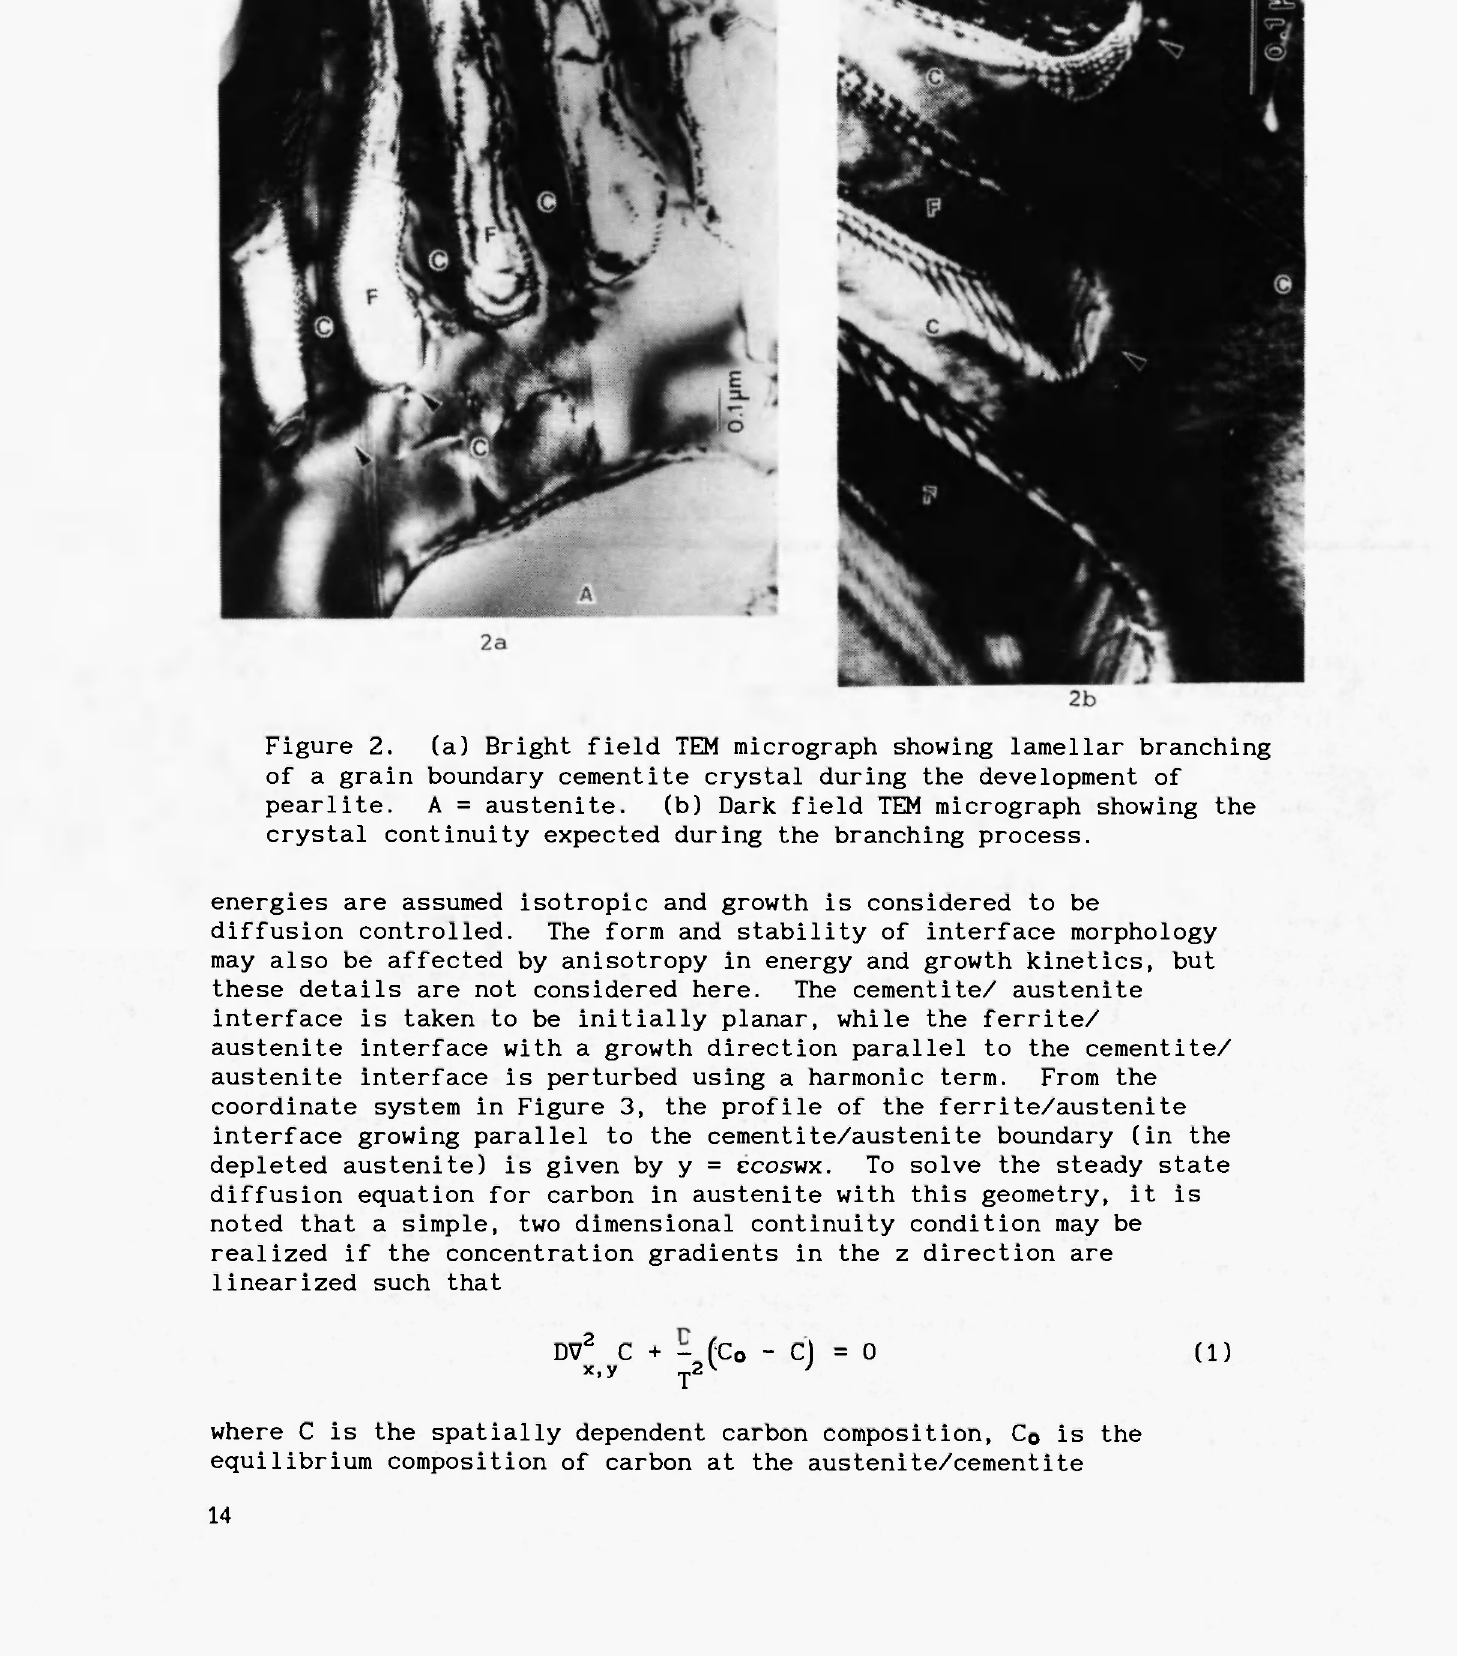
Figure 2. (a) Bright field TEM micrograph showing lamellar branching of a grain boundary cementite crystal during the development of pearlite. A = austenite. (b) Dark field TEM micrograph showing the crystal continuity expected during the branching